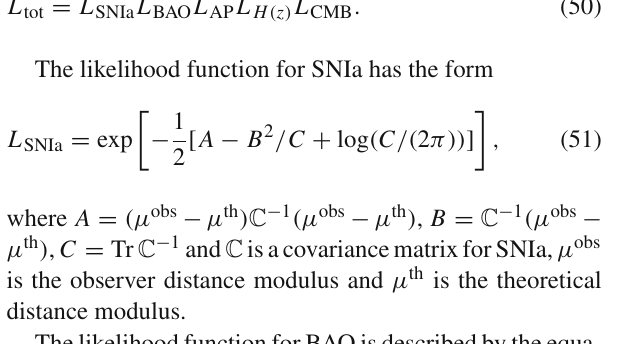
where AP ( z ) th ≡ H